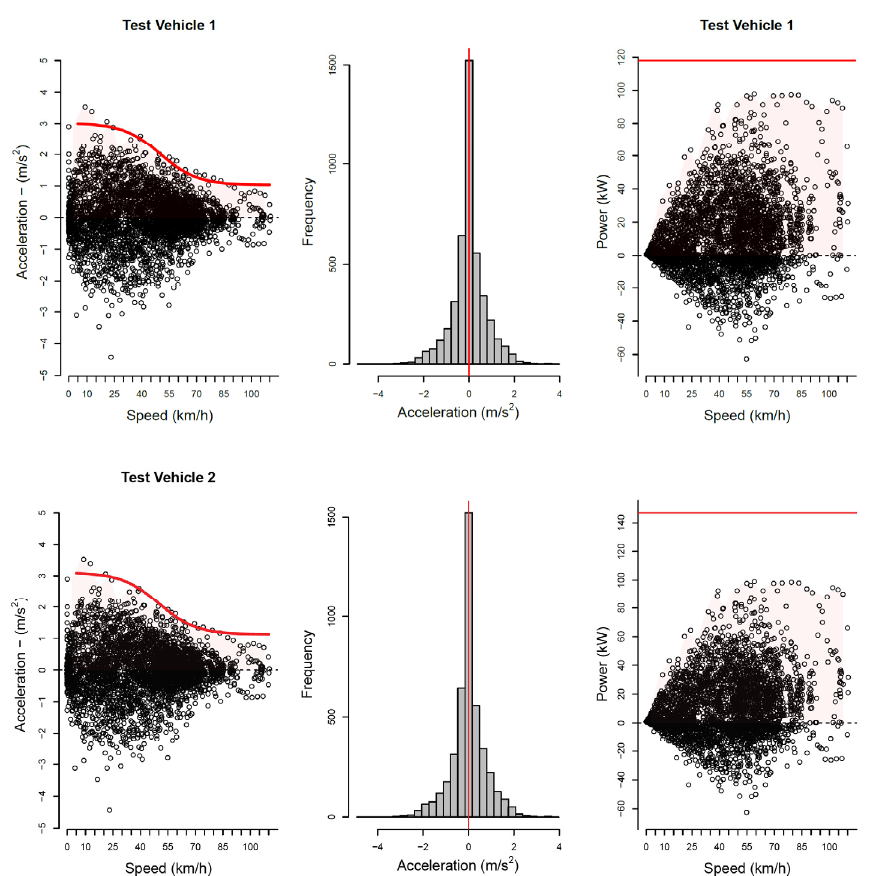
Figure 3. Simulation of test vehicles over Australian drive cycles. Red lines in left side plots show the binned (5 km/h bins) maximum acceleration values, red lines in centre plots show zero speed, and red lines in right side plots show rated engine power.